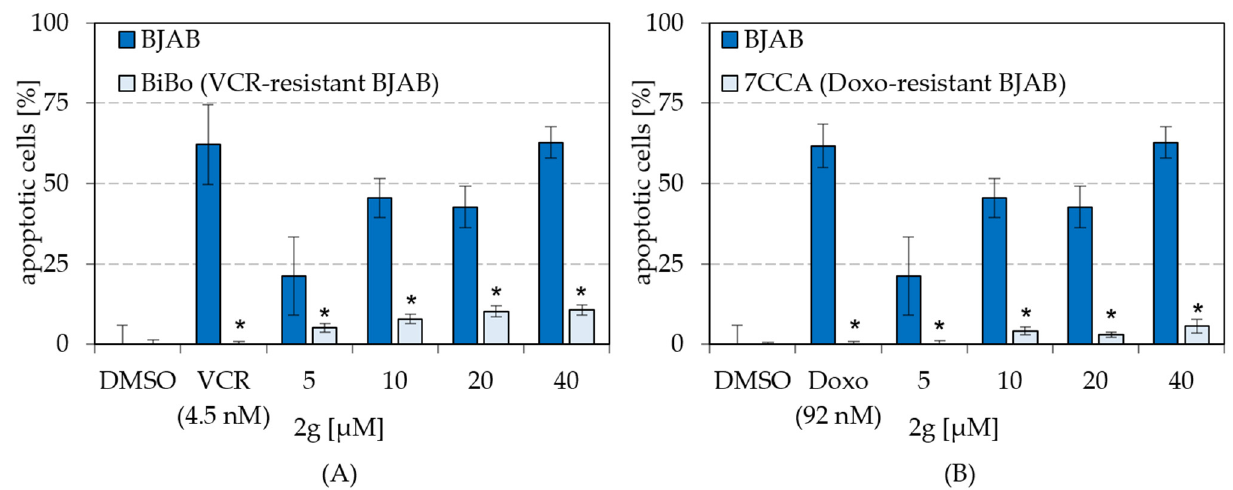
Figure 6. The 2g -induced apoptosis depends on Bcl-2 and caspase-3. BJAB cells as well as their corresponding resistant cell lines were treated with 2g for 72 h. As the solvent, control cells were treated with the same amount of DMSO as used for 2g . The cytostatic drugs were used to prove the resistance of the cells (( A ): VCR—vincristine, ( B ): Doxo—doxorubicin). After treatment, the induction of apoptosis was measured via flow cytometric analysis of DNA fragmentation. Three replicates were carried out per concentration. The mean values ± SD are shown (* p < 0.05 vs. corresponding concentration in BJAB, t